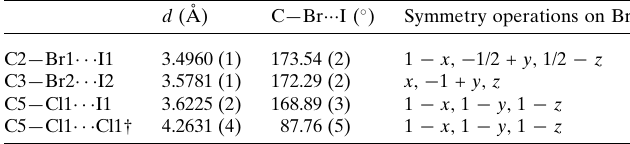
Symmetry operations on Br